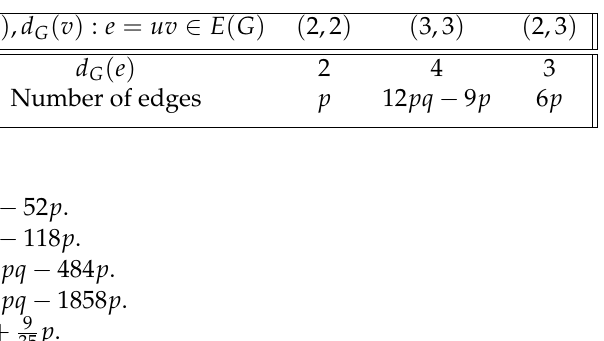
Table 5. Edge degree partition of SC 5 C 7 [ p , q ]